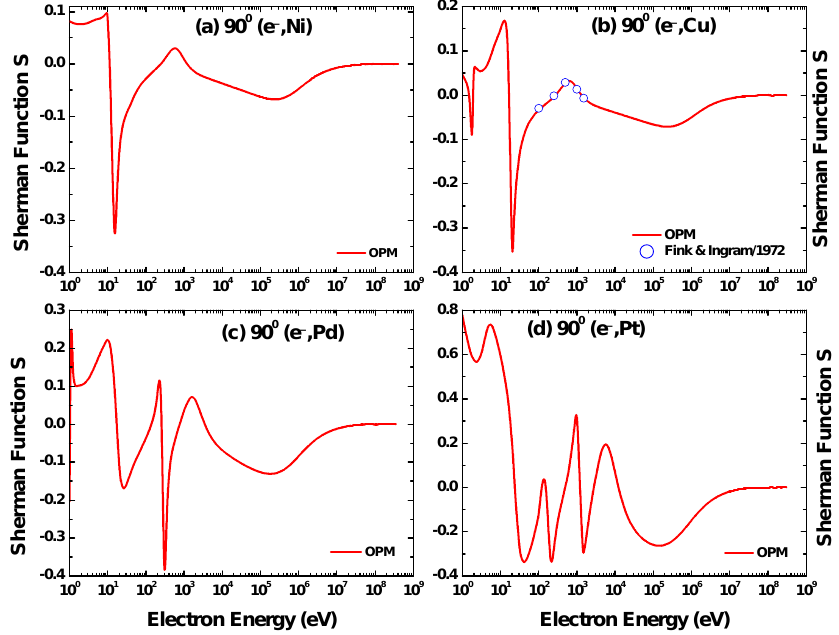
Figure 17. Energy-dependent Sherman function S for electron scattering from ( a ) Ni 58 , ( b ) Cu 63 , ( c ) Pd 108 , and ( d ) Pt 196 at a scattering angle of θ = 90 ◦ , in comparison with the calculations of Fink and Ingram [39] for Cu 63